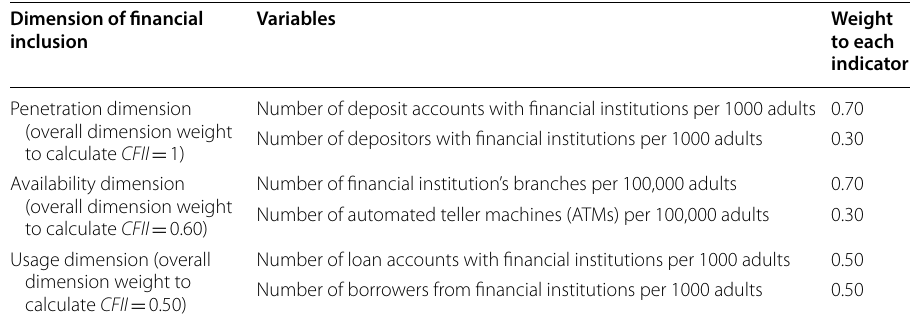
to each indicator